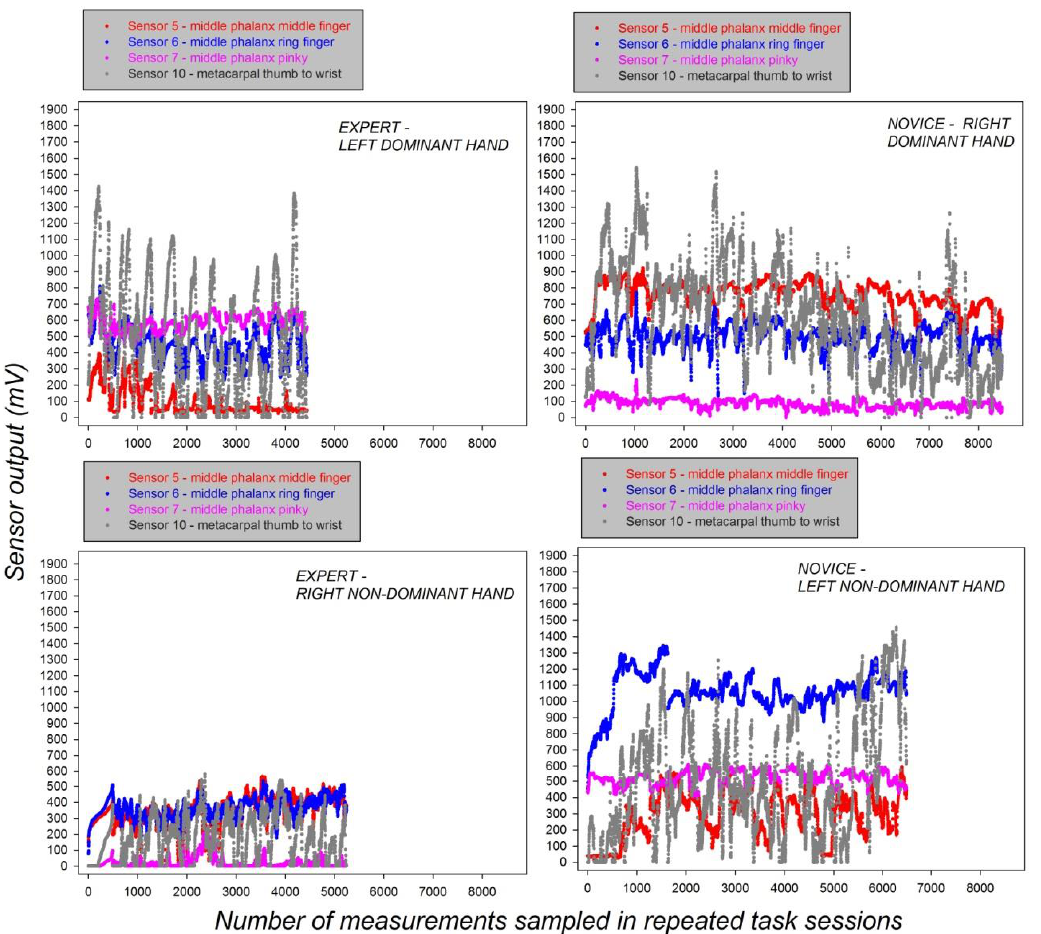
Figure 7. Grip force profiles of the expert ( left ) and the novice ( right ) from the relevant sensors for task execution with the dominant and the non-dominant hand across successive individual sessions.